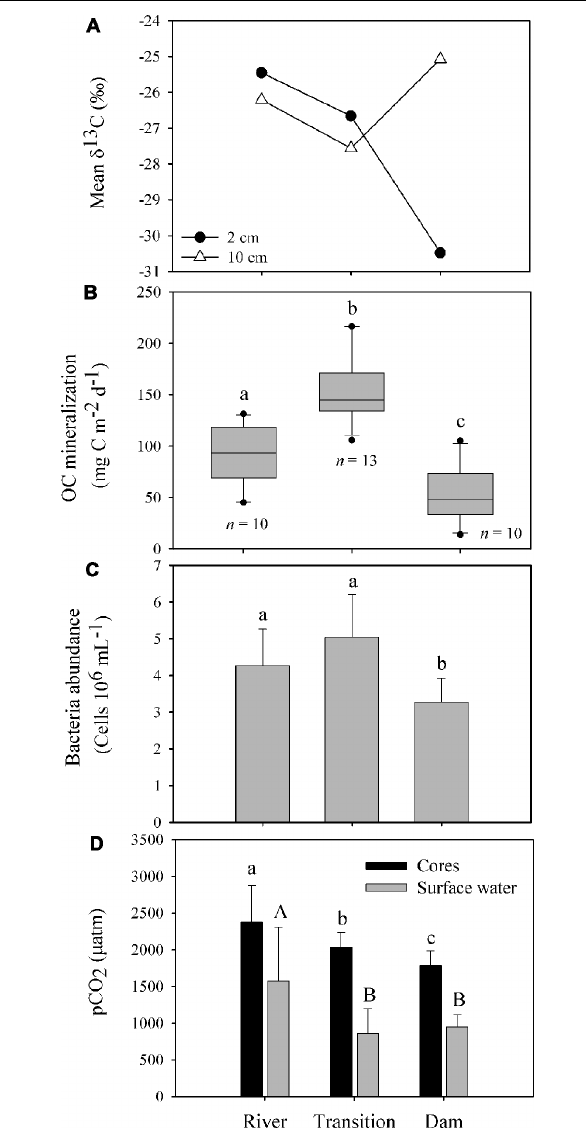
FIGURE 3 | Characteristics of OM composition, OC mineralization, bacteria abundance and partial pressure of CO 2 in the sediment of different zones of the Manso Reservoir. (A) Carbon isotope composition of the 2 and 10 cm of sediments sampled in different zones of the Manso Reservoir. (B) OC mineralization rates measured in the overlying water of sediment core incubations.The boundary of the box closest to zero indicates the 25th percentile, a line with the box marks the median, and the boundary of the box farthest from zero indicates the 75th percentile. Error bars above and below the box indicate the 90th and 10th percentiles and dark circles represent the outliers. (C) Mean and standard deviation of bacterioplankton abundance measured in the overlaying water of the sediment cores incubations. Small letters represent the differences between the p CO 2 from overlaying water of the sediment cores incubations (black bars) and capital letters represent the differences between the p CO 2 measure on the surface water of the reservoir (gray bars). (D) Means and standard deviations of partial pressure of CO 2 ( p CO 2 ) from the overlaying water of the incubation cores (black bars) and in the surface water of the reservoir (gray bars; data from Roland etal., 2010). In all panels different letters represent significant differences (one-way ANOVA,Tukey’s post hoc , p < 0.001).